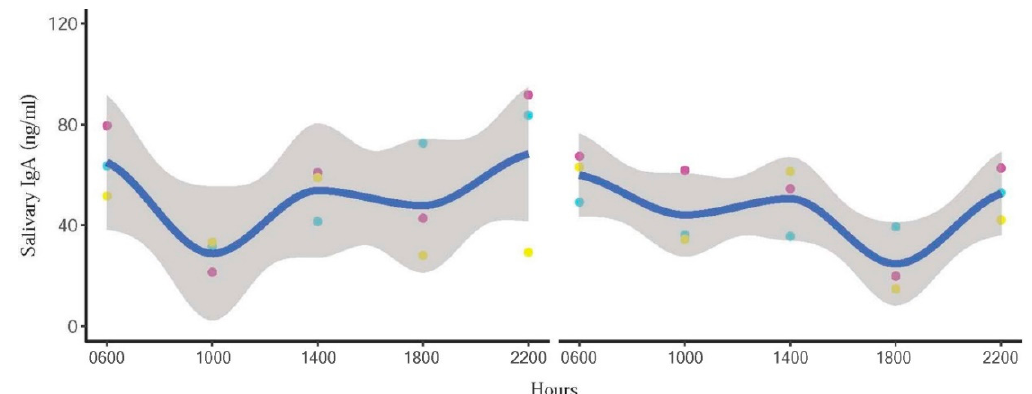
Figure 3. Representative individual profiles showing quartic circadian IgA trends in one male ( left ) and one female ( right ) elephant. Blue line represents the trend line, and the shaded area is a 95% confidence interval. Day 1 = red points, Day 2 = blue points, and Day 3 = yellow points.